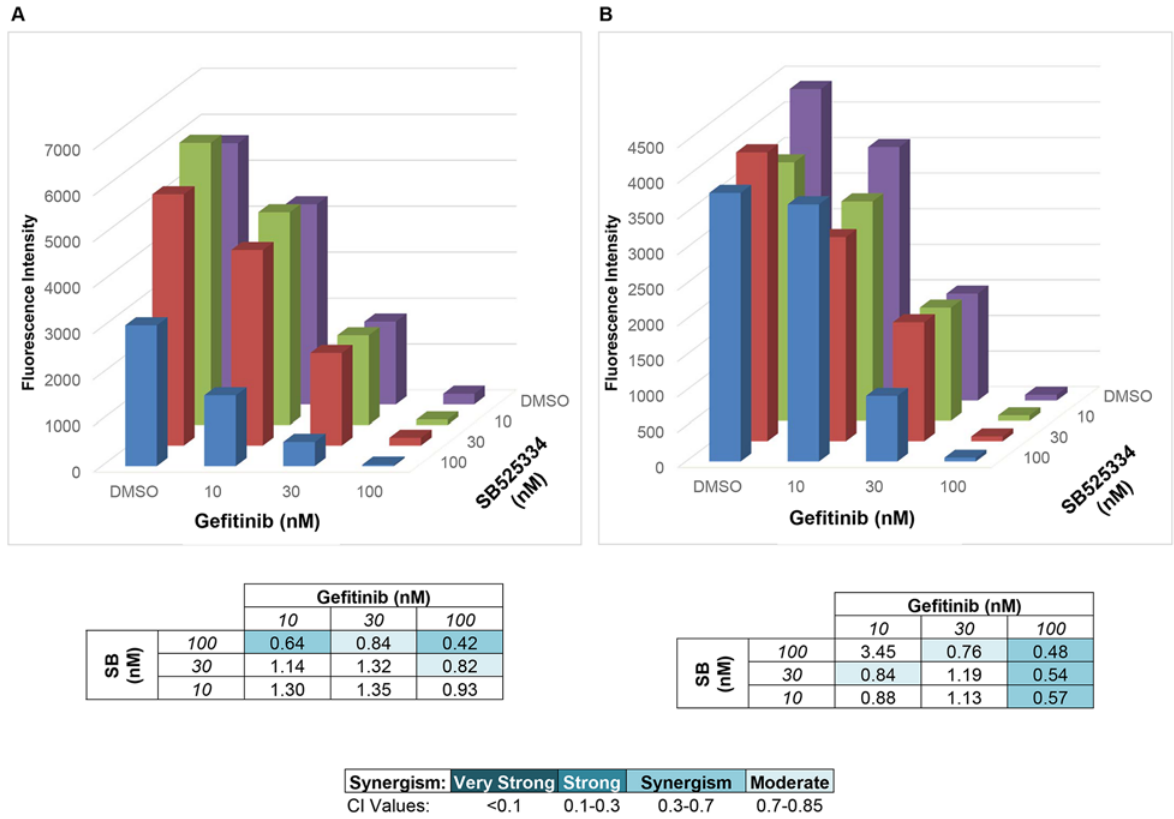
Fig 5. TKIs and SB525334 synergistically inhibit proliferation of UMSCC25 cells. A CyQUANT Direct Cell Proliferation Assay was performed on UMSCC25 cells treated with a concentration range of gefitinib and SB525334, alone and in combination. The experiment was performed in the absence ( A. ) or presence ( B. ) of 0.3 μ M AZD4547. The combinatorial indices (CI) were calculated with CalcuSyn Software and are presented in the tables below each